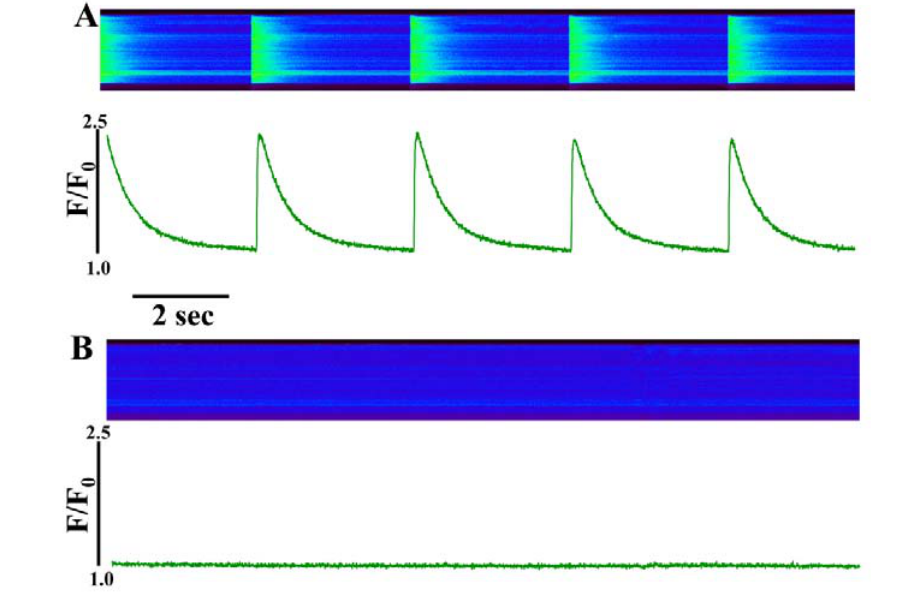
Figure 1. Perfusion of intact ventricular cardiomyocytes with a high concentration (30 µM) of IpTxa causes immediate cessation of [Ca 2+ ] transients. (A) line-scan image i (top) and associated fluorescence plot (bottom) of a field-stimulated mouse ventricular cardiomyocyte loaded with the Ca 2+ indicator Fluo-4 and perfused constantly with normal Tyrodes solution in the absence of IpTxa (control). (B) The same cell ~1 min after perfusion with the same Tyrodes solution, but containing 30 µM IpTxa. The protocol was repeated four times and the result below is representative of three experiments.